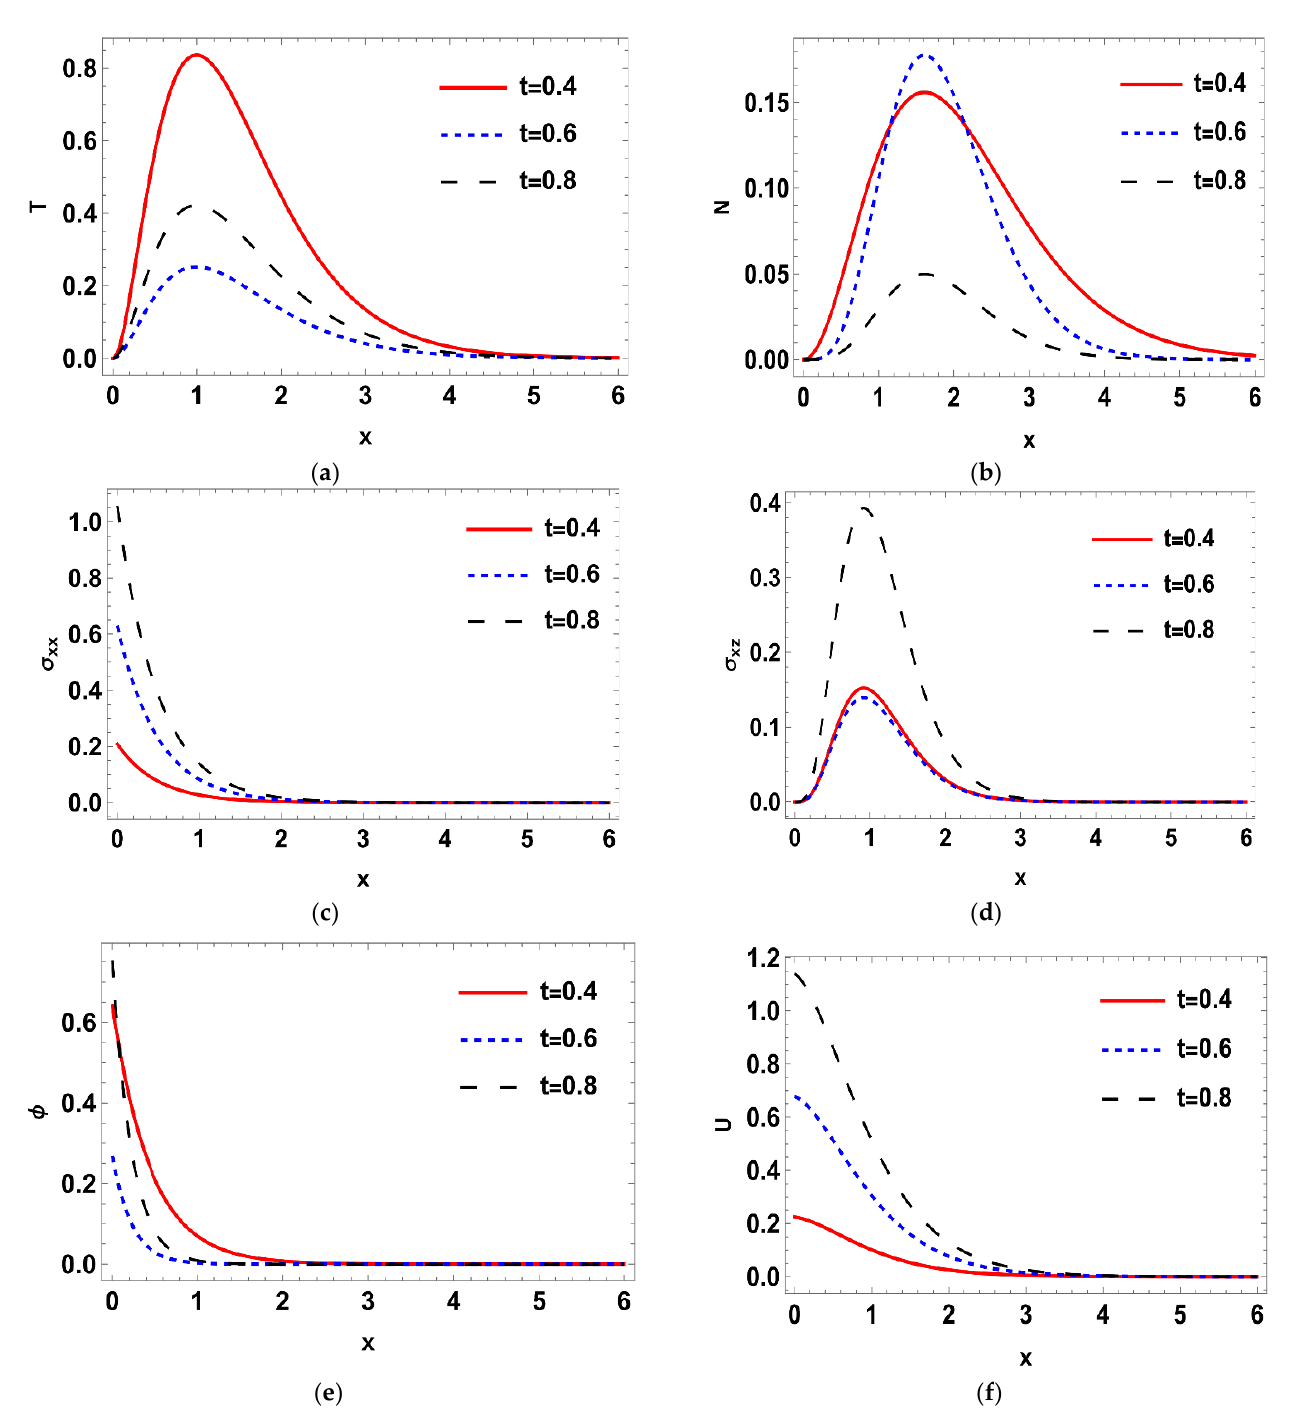
Figure 3. ( a – f ) The variance of temperature, normal stress, carrier density, displacement and heat conduction distributions around its mean at different values of times t = 0.2, t = 0.4 and t = 0.6 when 5 a = .